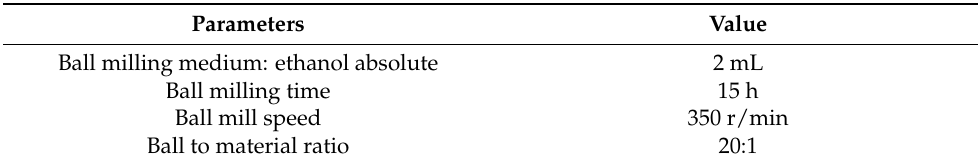
Table 1. The parameters of ball